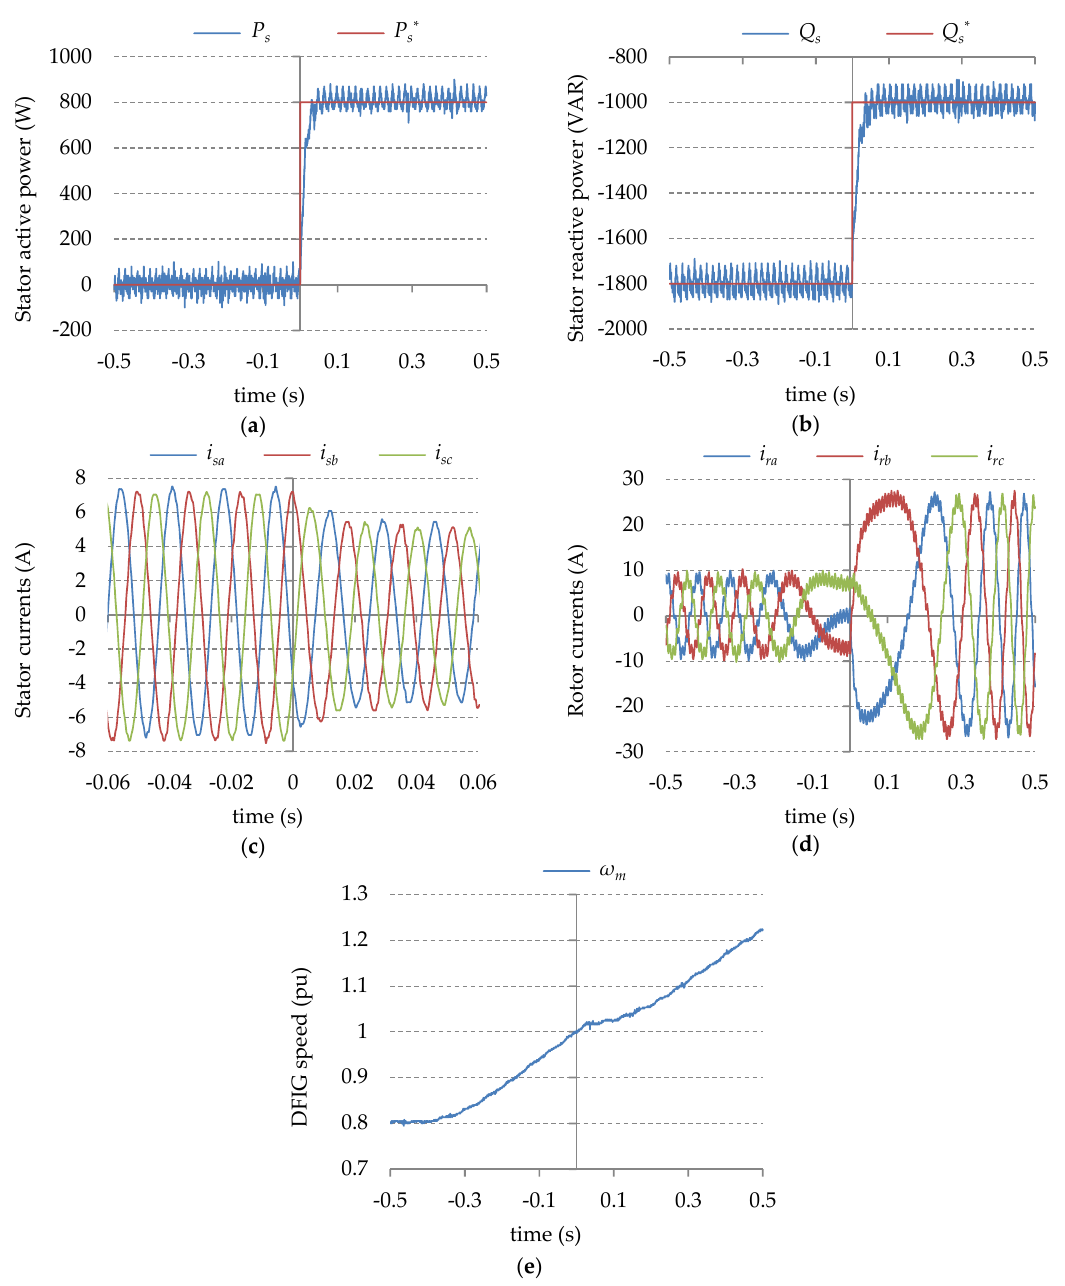
Figure 11. Experimental results for variable speed operation ( ω m = 0.8 pu → 1.2 pu): ( a ) stator active power; ( b ) stator reactive power; ( c ) stator currents; ( d ) rotor currents; ( e ) DFIG’s speed.